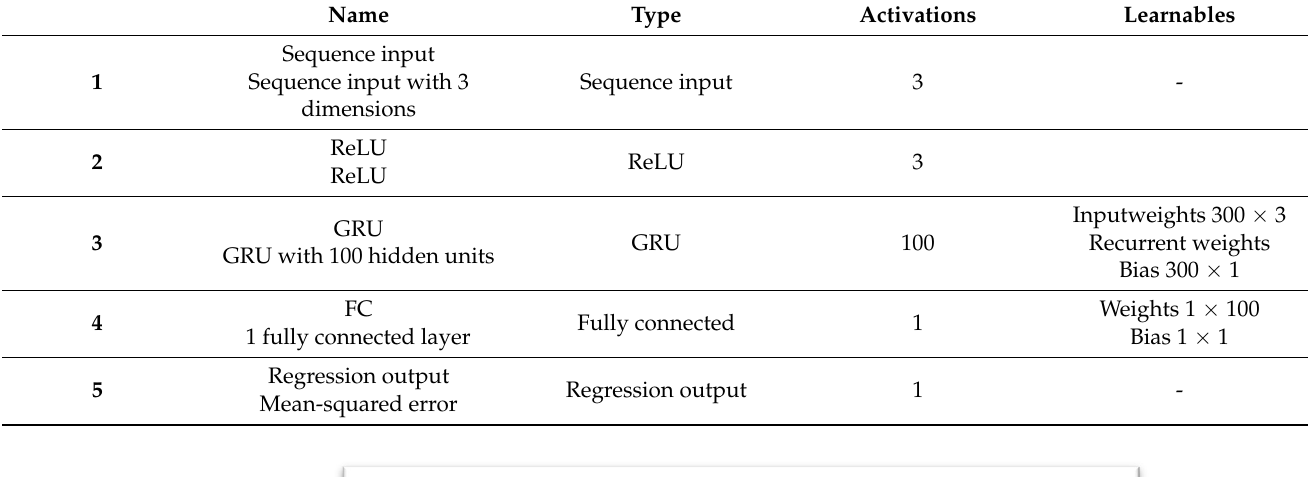
Table 3. Network analysis for proposed GRU model.